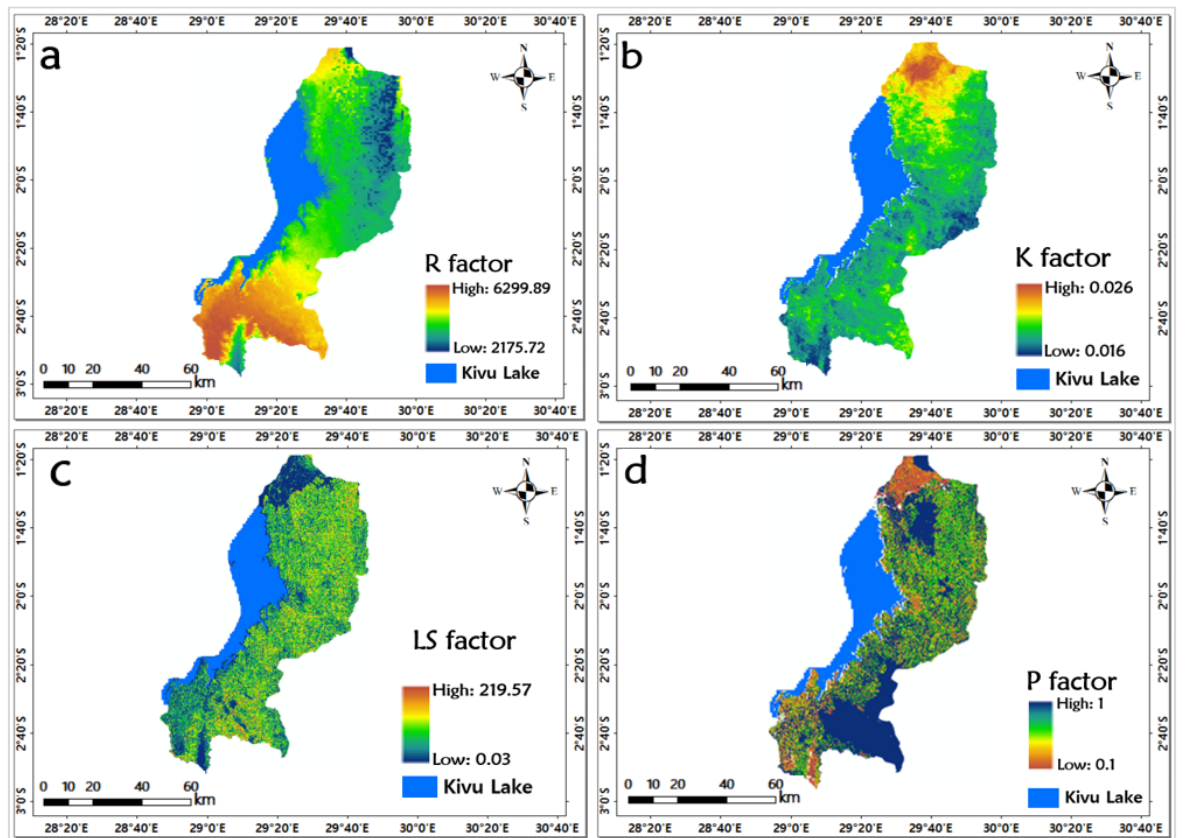
Figure 2. RUSLE factor maps for the western province of Rwanda: ( a ) rainfall erosivity (R) factor; ( b ) soil erodibility (K) factor; ( c ) slope length and its steepness (LS) factor; ( d ) support practice (P) factor.